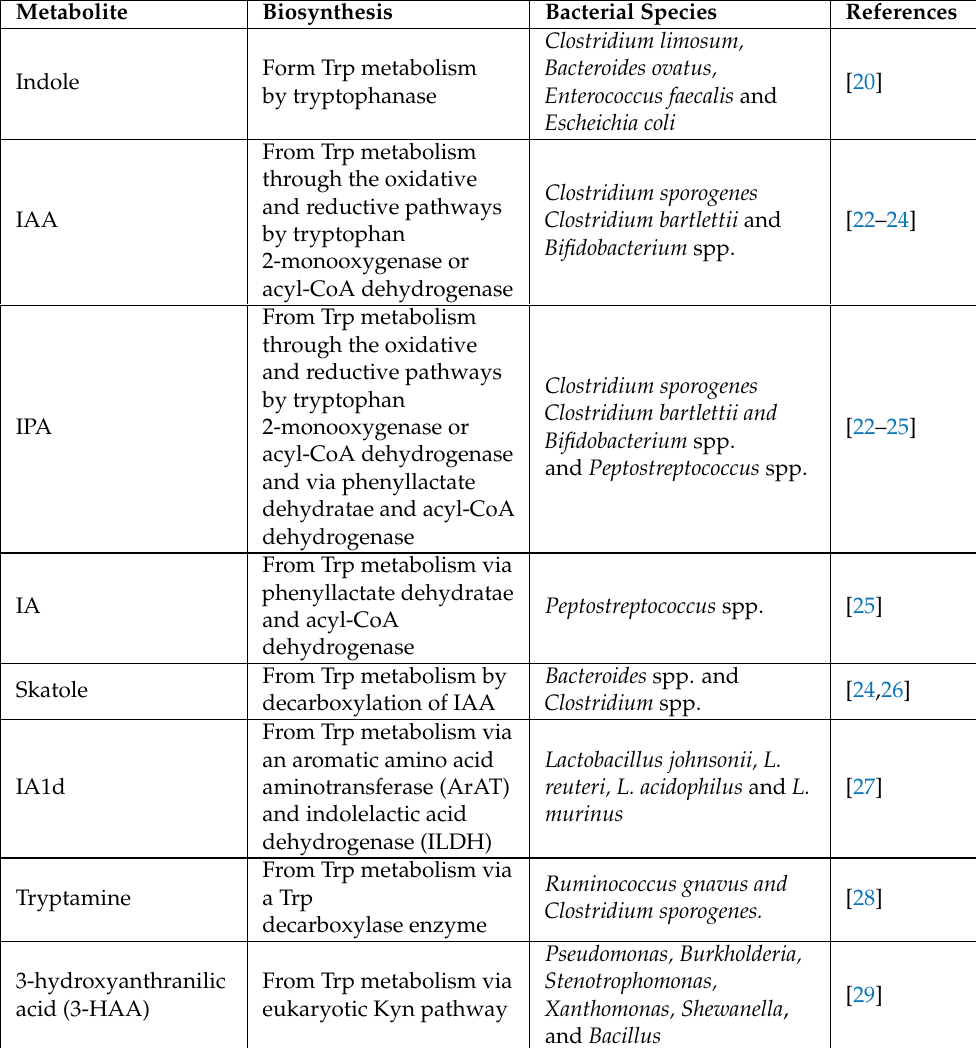
Table 2. Gut microbiota species and tryptophan